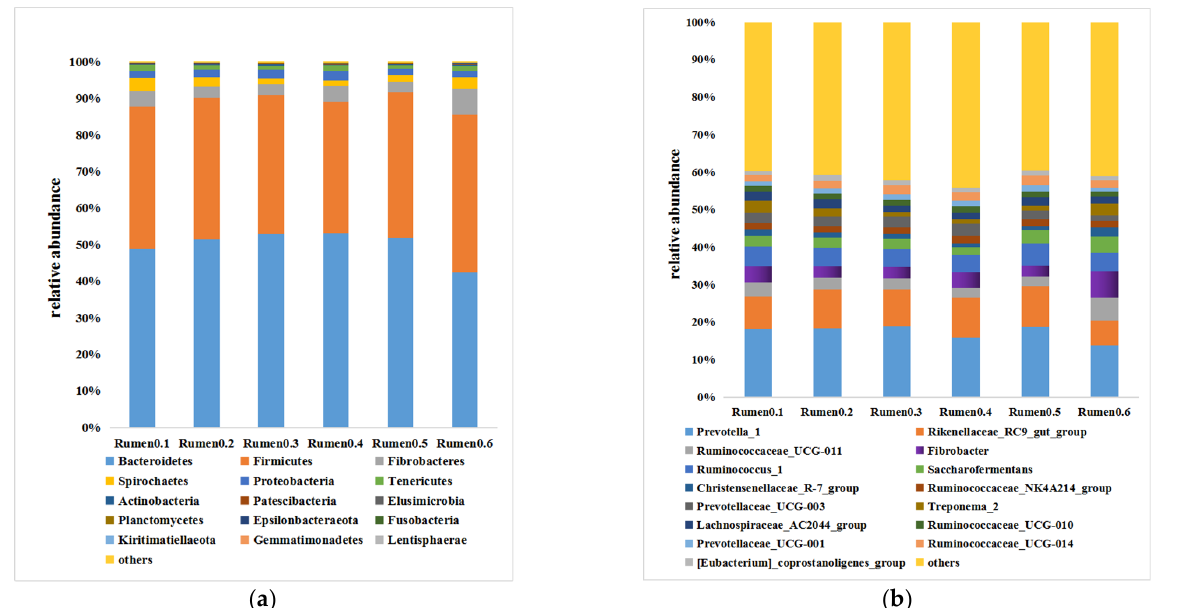
Figure 2. ( a ) Composition of rumen microorganisms at phylum level; ( b ) composition of rumen microorganisms at genus level . Notes: Rumen0.1, Rumen0.2, Rumen0.3, Rumen0.4, Rumen0.5 and Rumen0.6 represent the name of six rumen con-